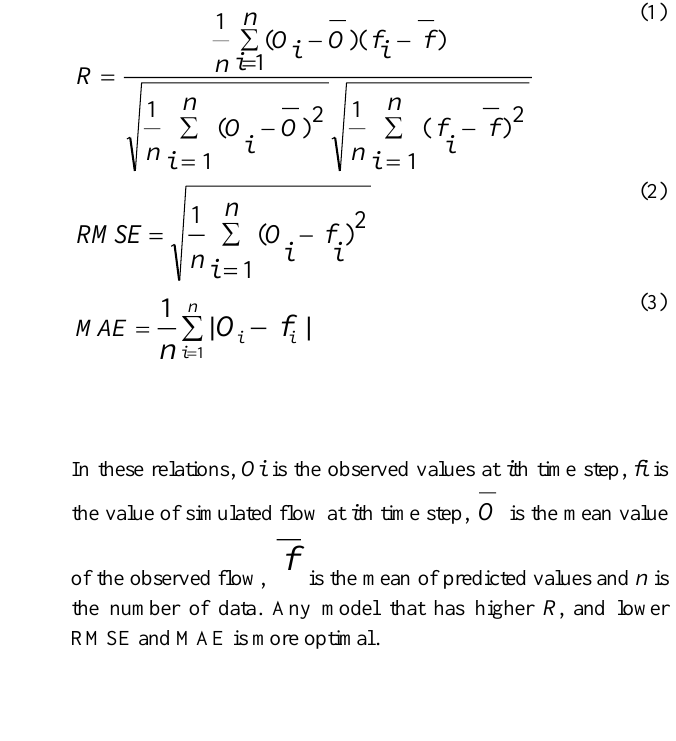
Table 1: The values of the efficacy criteria for comparing satellite data with daily precipitation data at Tamer